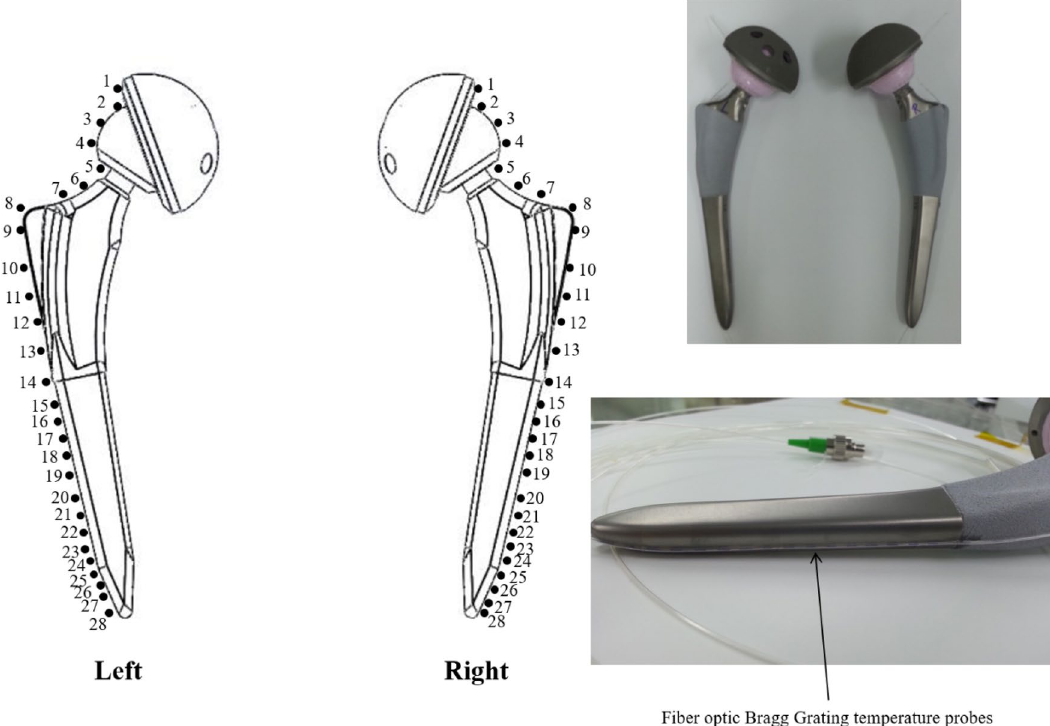
Figure 6. Schematic diagram and photographs showing the locations of fiber-optic Bragg grating (FBG) temperature sensors around artificial hip